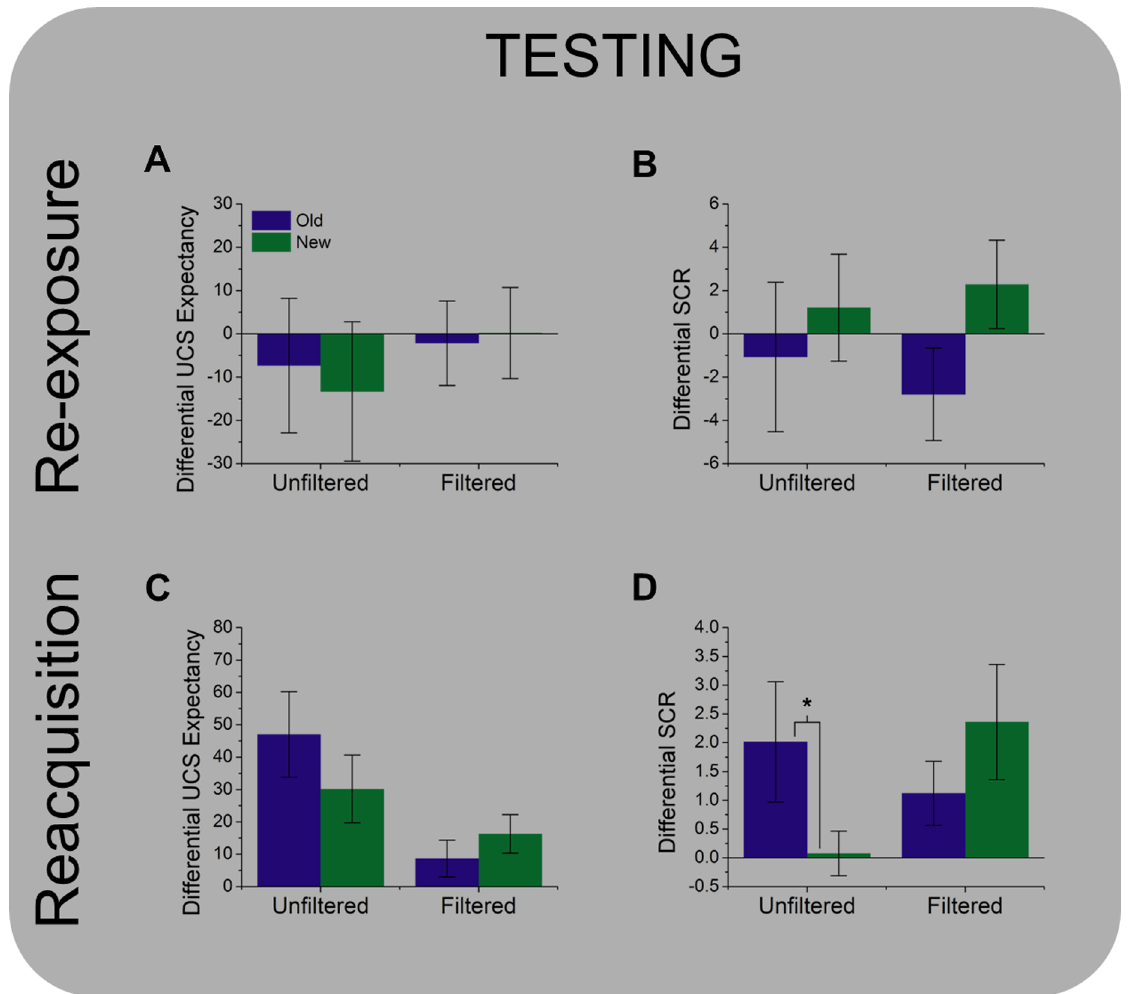
Figure 1. Trace fear conditioning with masked face CSs affects performance in a subsequent reacquisition task. During the training session, subjects were presented with masked filtered and unfiltered face stimuli. Stimuli were presented for 30 ms and immediately followed by a 970 ms presentation of a masking stimulus. The UCS was presented after the 900 ms trace interval on all CS + trials. ( A, B ) Trace fear conditioning with masked face CSs does not appear to affect differential UCS expectancy ( A ) or differential SCR expression ( B ) during a subsequent unmasked re- exposure to the stimuli. C. Similarly, trace fear conditioning with masked face CSs does not affect subsequent differential UCS expectancy during a subsequent reacquisition session. D. In contrast, trace fear conditioning with masked unfiltered, but not filtered faces, affects subsequent differential SCR expression during a subsequent reacquisition session. Bars represent the mean 6 SEM. (* p , 0.05).